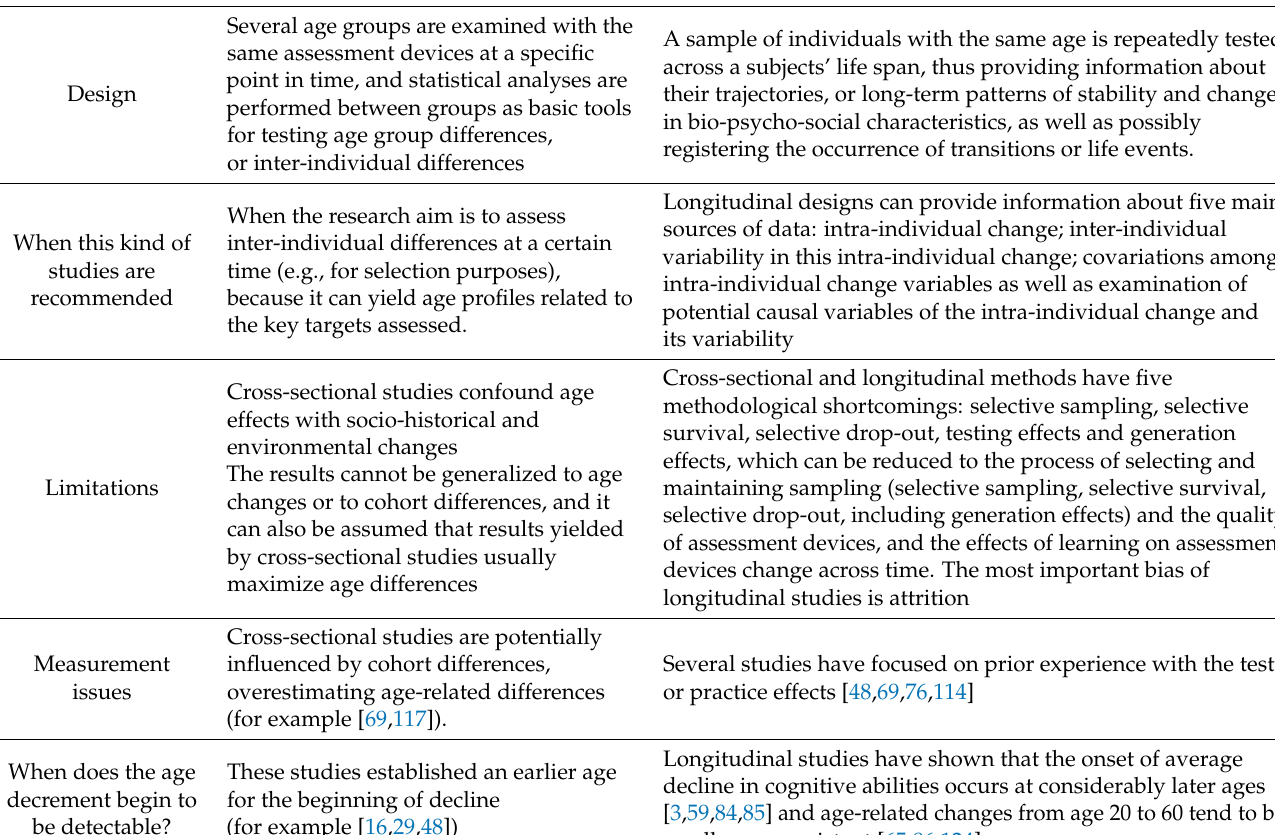
Table 1. Some discrepancies between cross-sectional and longitudinal studies. Cross-Sectional Studies Longitudinal